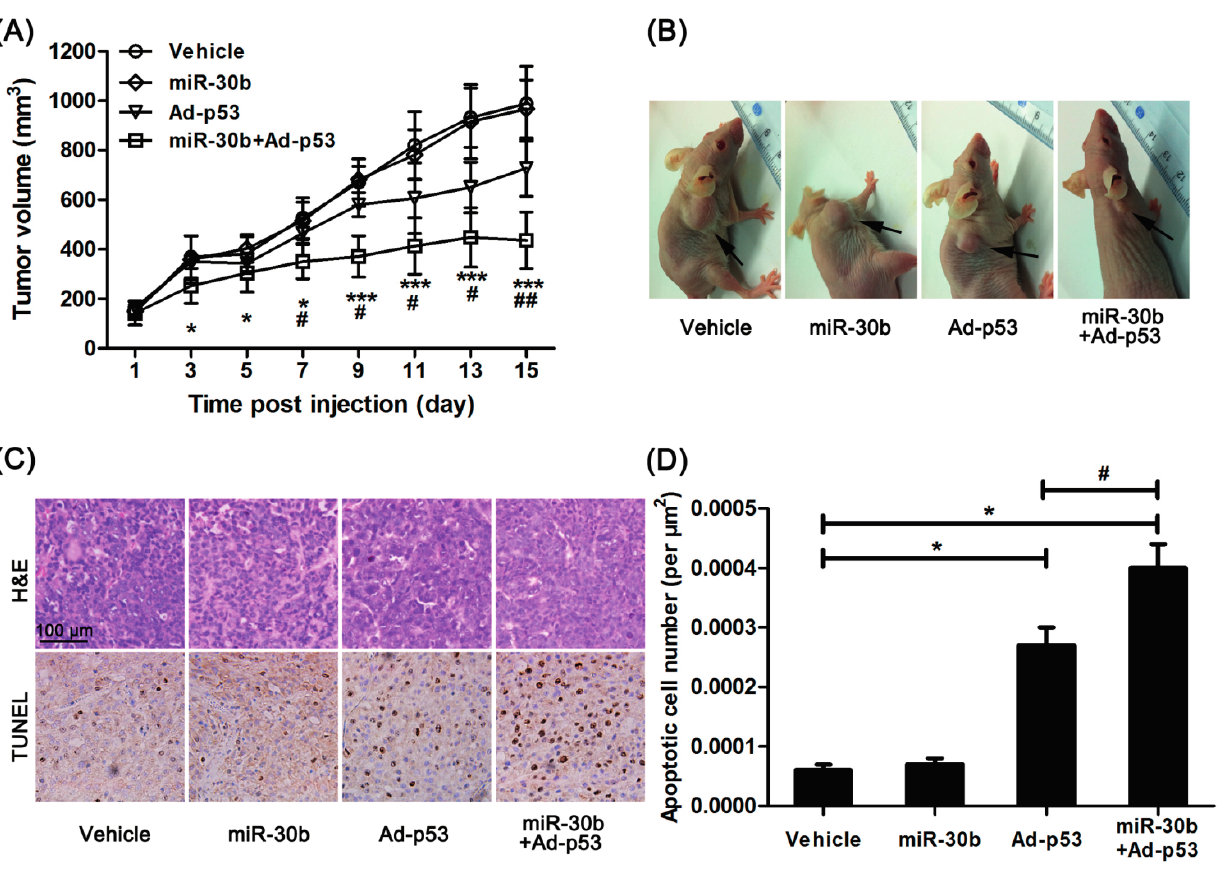
Figure 3. Overexpression of miR-30b improved the anti-tumor effect of Ad- p53 in vivo . ( A ) After Ad- p53 injection, tumor volume was calculated every two days, * p < 0.05, *** p < 0.005 compared to normal HEp-2 cell-implanted nude mice, # p < 0.05, ## p < 0.01 compared to Ad- p53 -treated implanted mice, n = 8; ( B ) After 15 days injection, the tumor in nude mice was pictured, the black arrow in the representative figure indicating tumor position; ( C ) After the experiment, the tumor tissue was removed and made into sections. H&E and TdT-mediated dUTP nick end labeling (TUNEL) staining were performed. Brown showed TUNEL-positive nuclei, and all nuclei were stained with hematoxylin. Scale bar = 100 μ m and referred to all panels; and ( D ) Apoptotic cell number was calculated as TUNEL-positive number divided by total cells. * p < 0.05 compared to normal HEp-2 cell-implanted nude mice, # p < 0.05 compared to Ad- p53 -treated implanted mice, n =